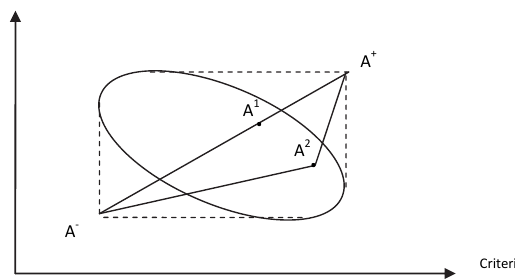
Fig. 2. The target interval is the ideal solution between two criteria: positive and negative In this method, in addition to the distance of an alternative the ideal point of A i , its distance from